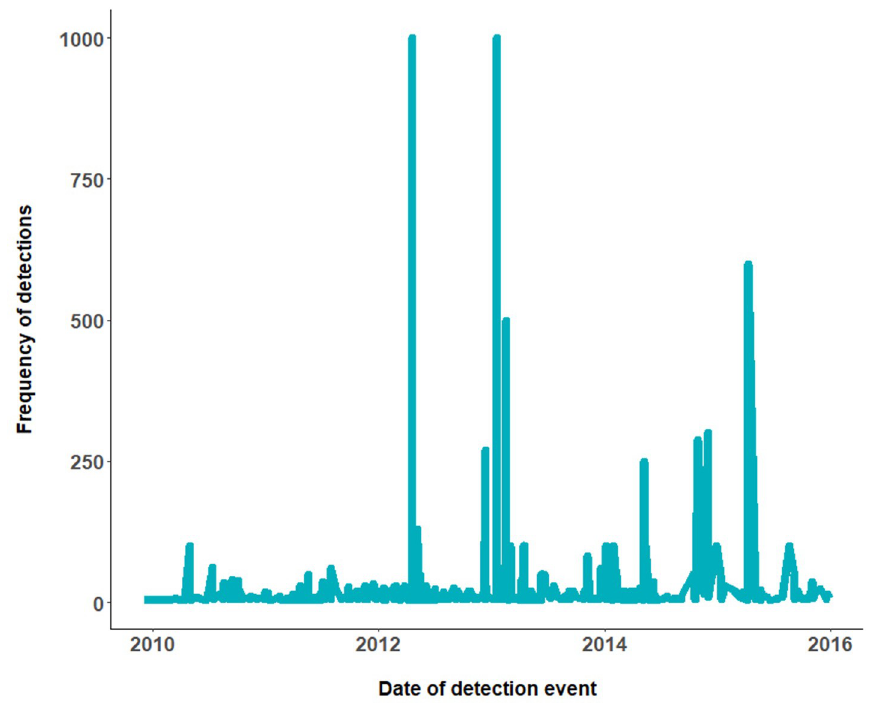
Fig 8. Time series model for biosecurity border detection counts between January 2010 and September 2015 for cluster 2 using data from Barrow Island. N.B. The majority of the detections were single unit detections, with extreme counts of 1000 counts also observed.